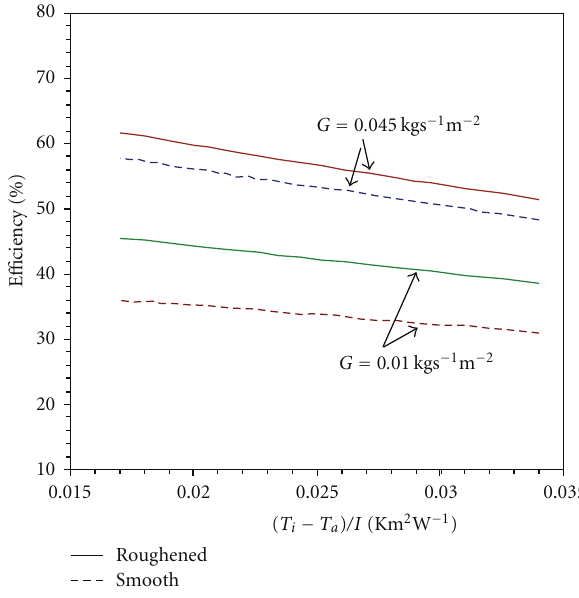
F 5: Enhancement in thermal performance due to arti�cial roughness